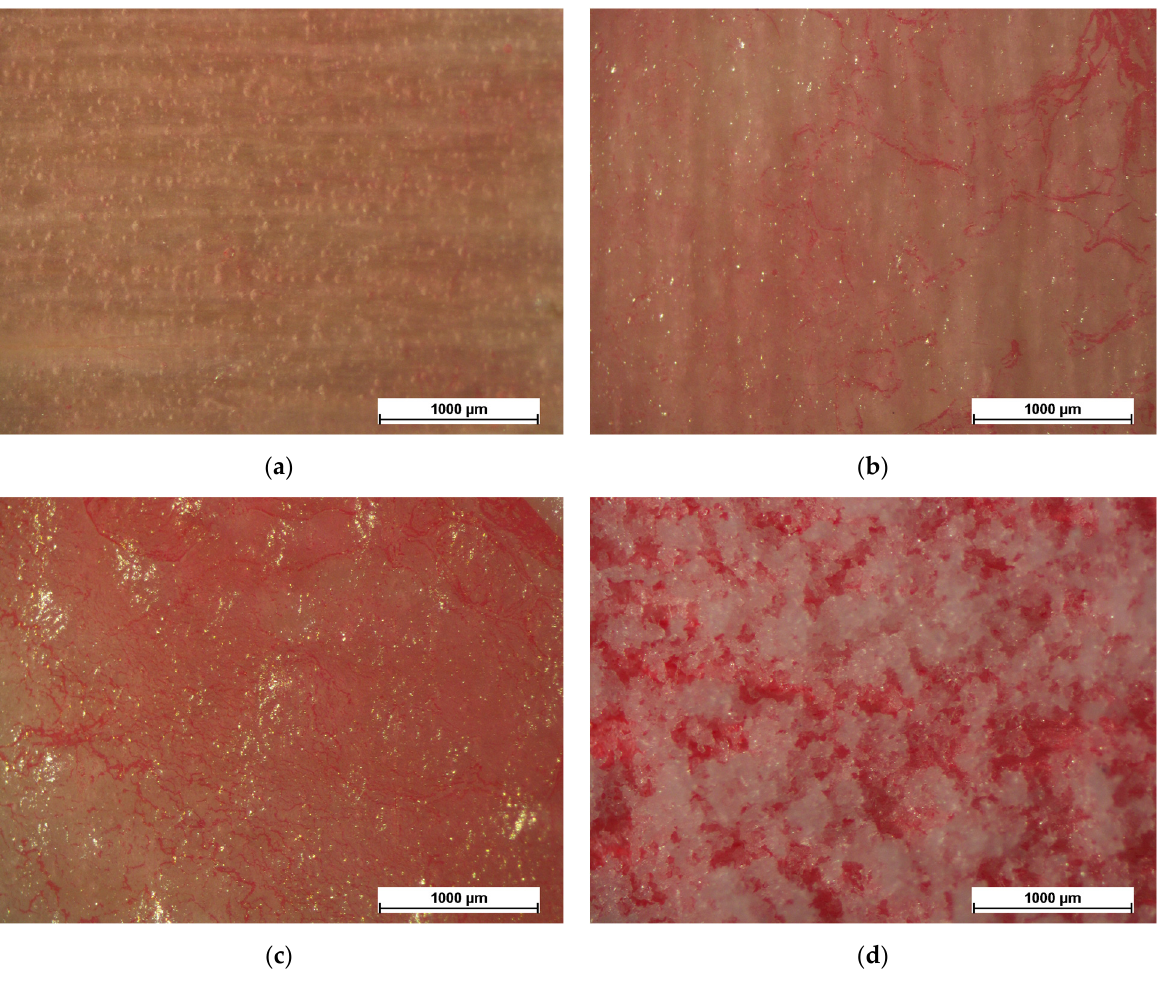
Figure 9. Appearance of ( a ) sample F0, ( b ) sample F5, ( c ) sample F10 and ( d ) sample